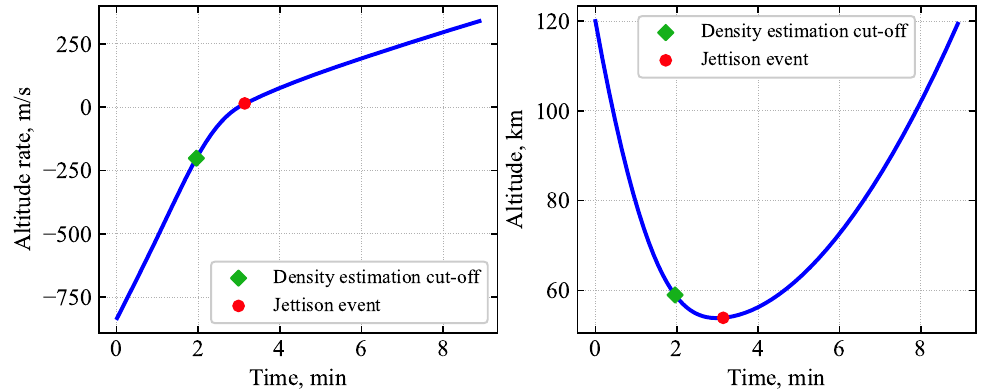
Figure 9. Evolution of altitude rate and altitude during Mars aerocapture. The green diamond indicates the time when a preset altitude rate threshold ( − 200 m/s) is exceeded, at which point density estimation is cut off and apoapsis prediction is initiated. The red circle indicates the jettison event.